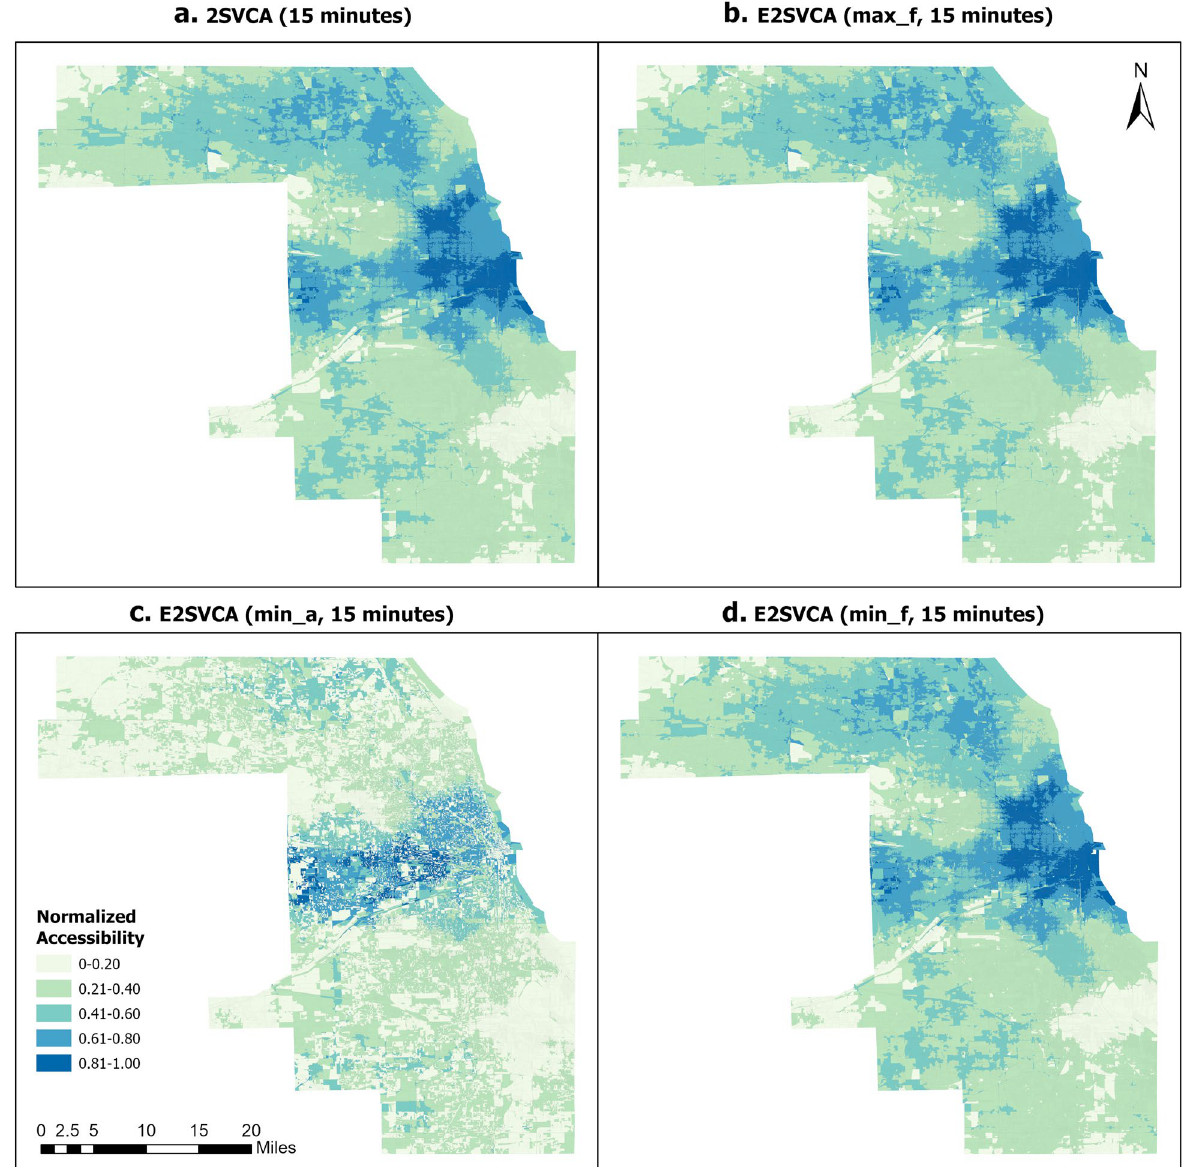
Fig. 4 Normalized 15 min 2SVCA and E2SVCA